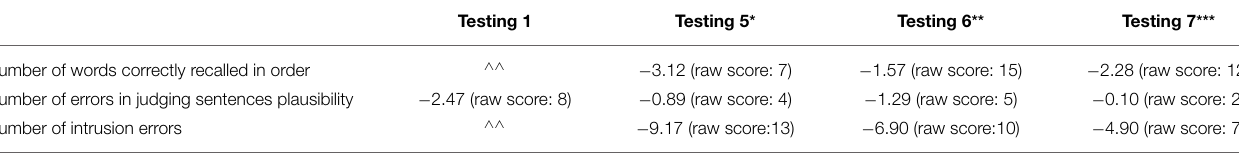
TABLE 3B | Effects of treatment on verbal working memory analyzed with standardized and raw scores (listening span test, Pazzaglia et al.,